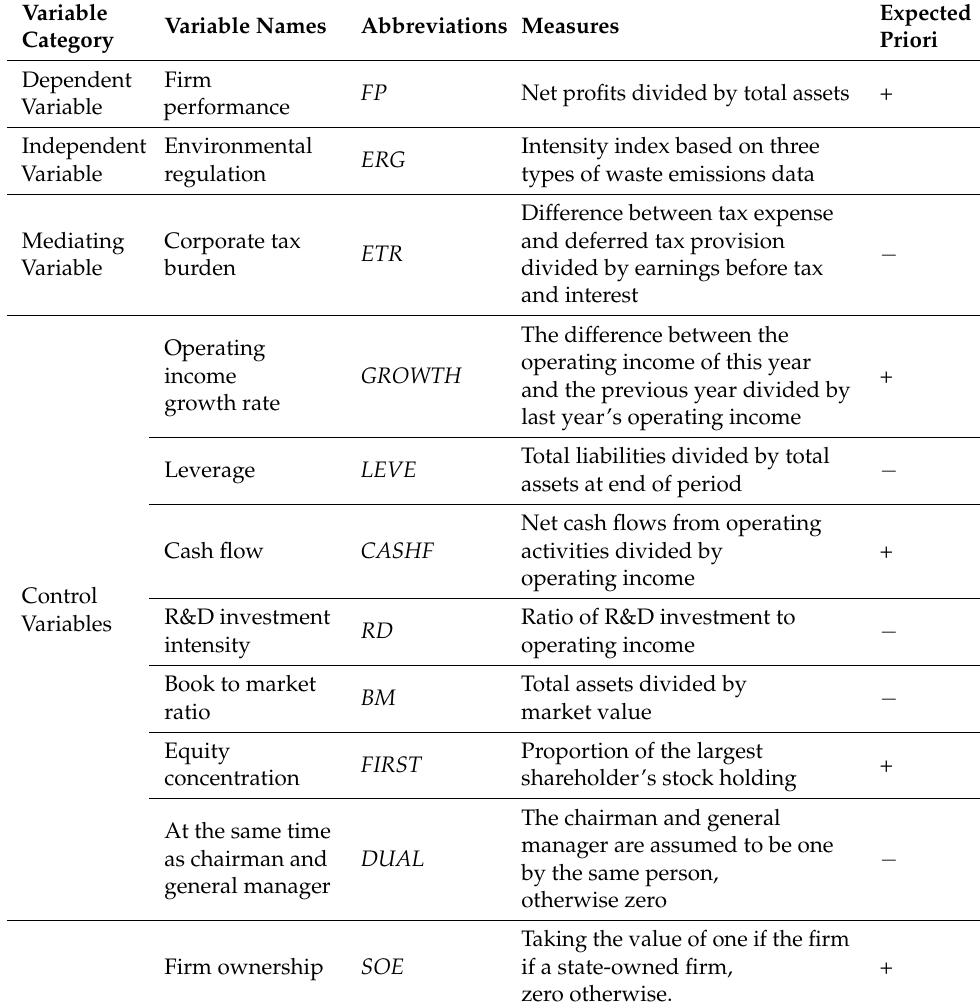
Table 1. Definition of